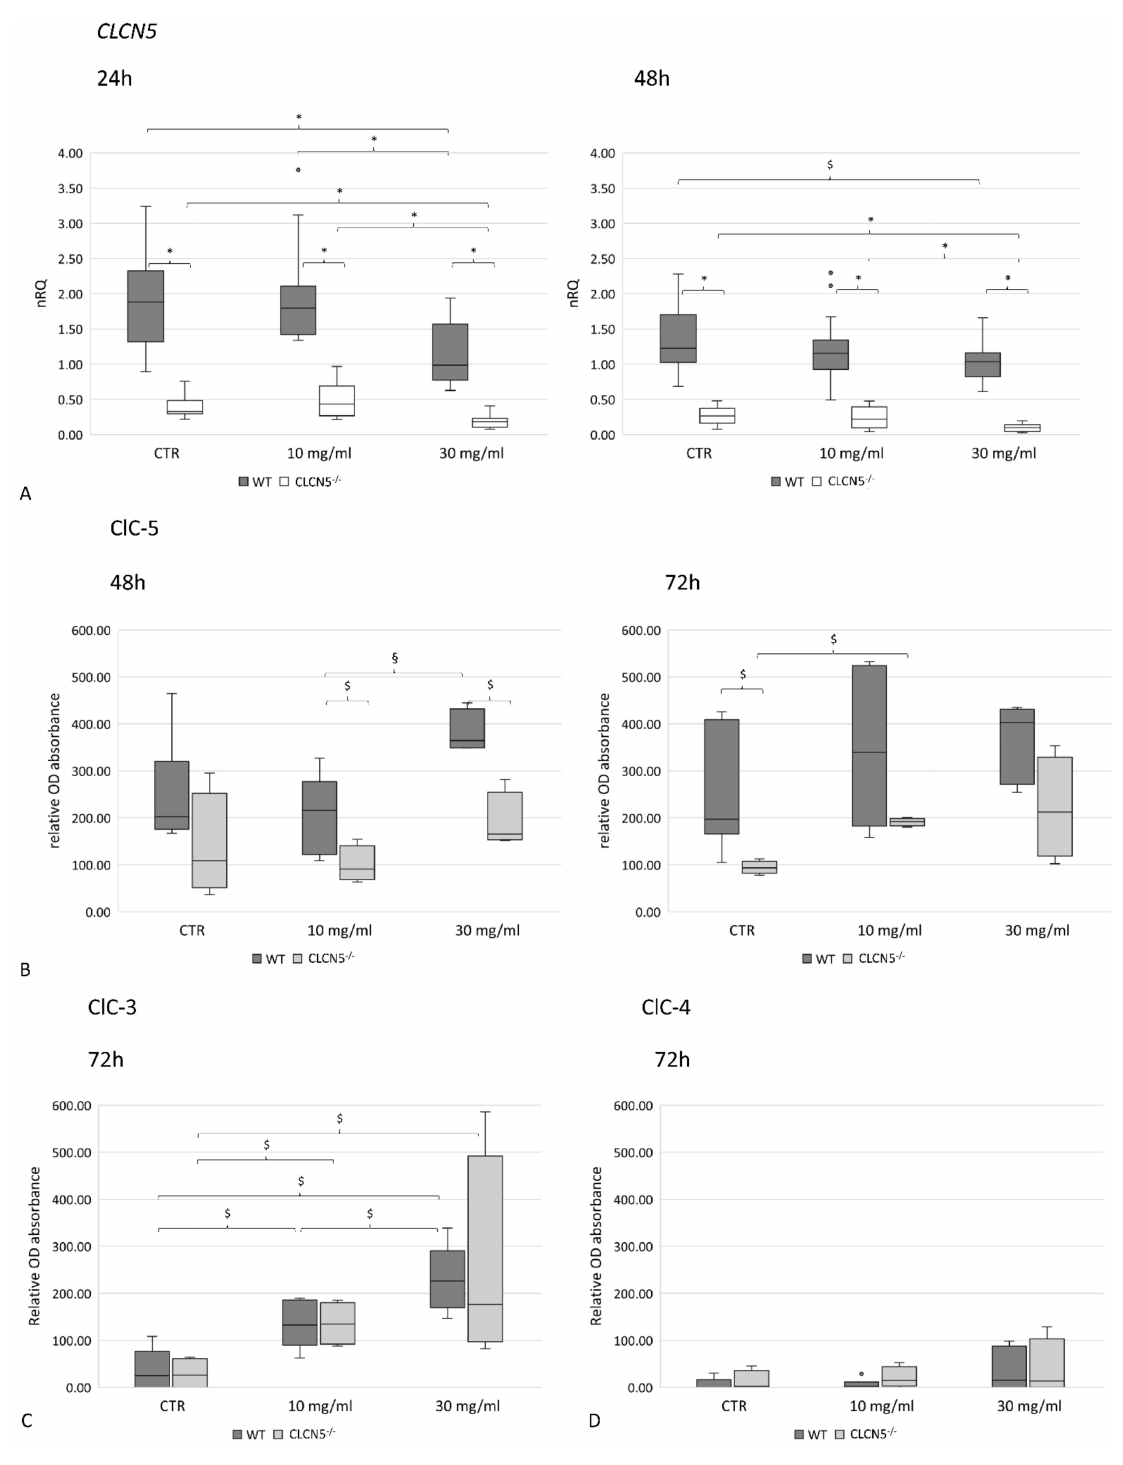
Figure 8. ClC-5, ClC-3, and ClC-4 expression in control WT and CLCN5 − / − clones following albumin treatment. Boxplots shows medians and interquartile ranges of ( A ) relative CLCN5 mRNA, as determined by qRT-PCR, and ClC-5 ( B ), ClC-3 ( C ), and ClC-4 ( D ) protein expression as determined by ICW. p -values were obtained with the Mann–Whitney U test. * p < 0.001; § p < 0.005; $ p < 0.05. Results are from two independent experiments performed in triplicate (qRT-PCR) and in quadruplicate (ICW). Abbreviations: nRQ: normalized relative quantity; OD, optical density, CTR: unstimulated